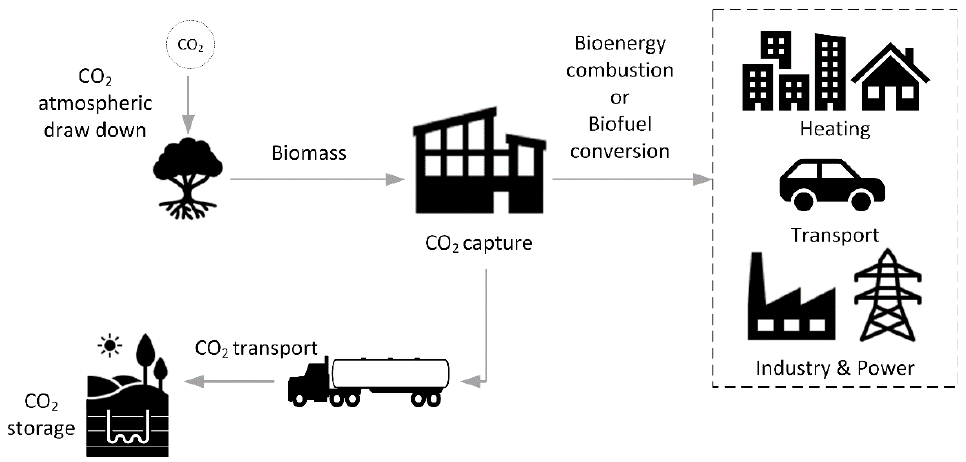
Figure 3. The concept of BECCS technology (adapted from [15]).